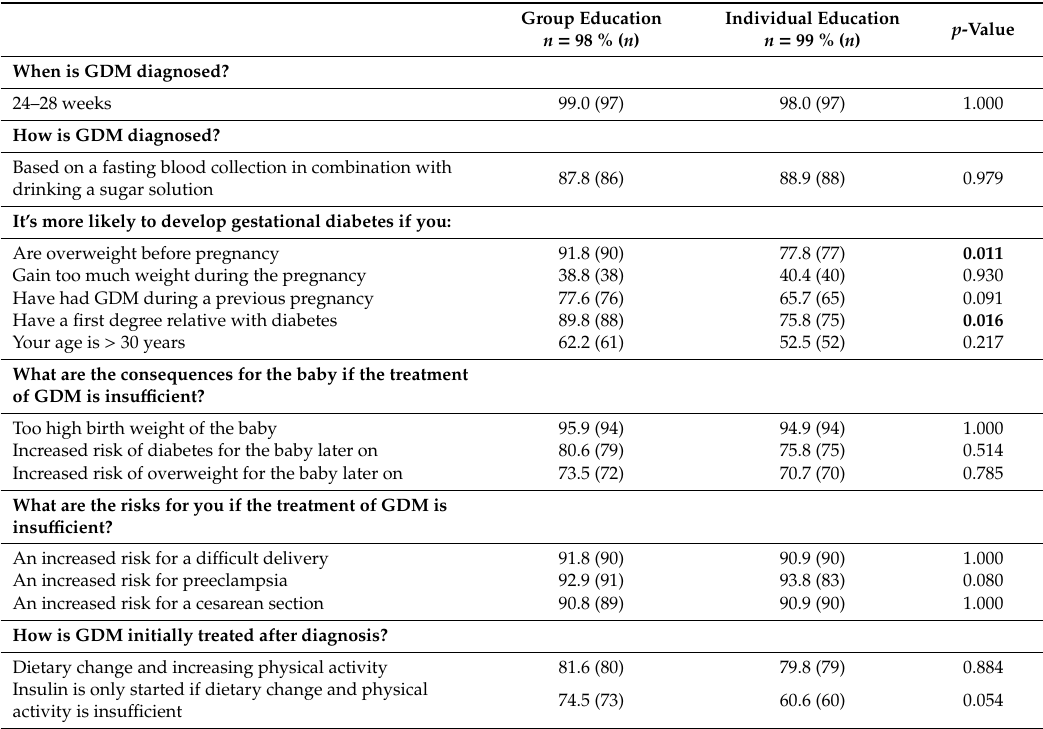
Table 5. Comparison of correct responses on the knowledge questionnaire between group